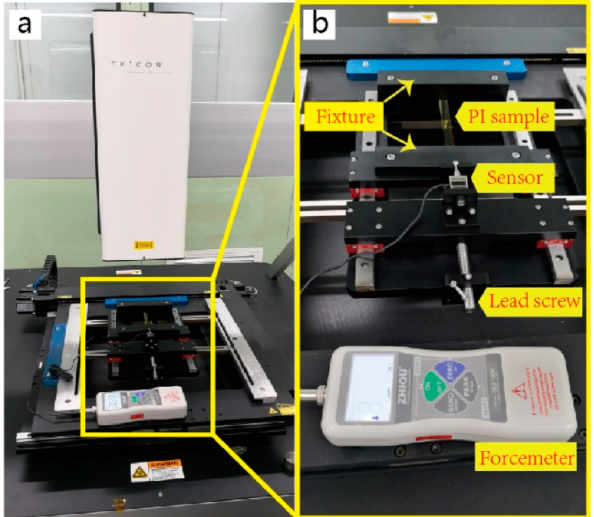
Figure 2. Experimental setup ( a ), uniaxially stretched PI membrane sample placed at center of Exicor 300AT instrument, and PI membrane stretching device ( b ), which consists of fixture, lead screw, force- meter, and